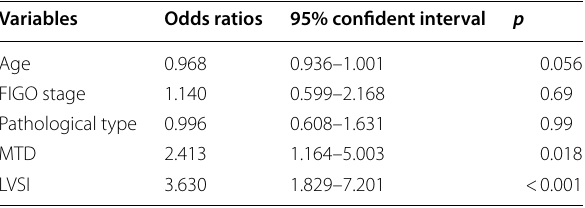
FIGO: International Federation of Gynaecology and Obstetrics; MTD: maximum tumor diameter; LVSI: lymph-vascular space invasion